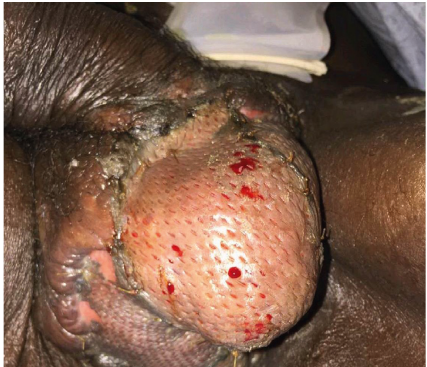
Figure 6: Photographic image of the patient’s reconstruction using 1-to-1 meshed split-thickness skin grafts to the testicles to create a